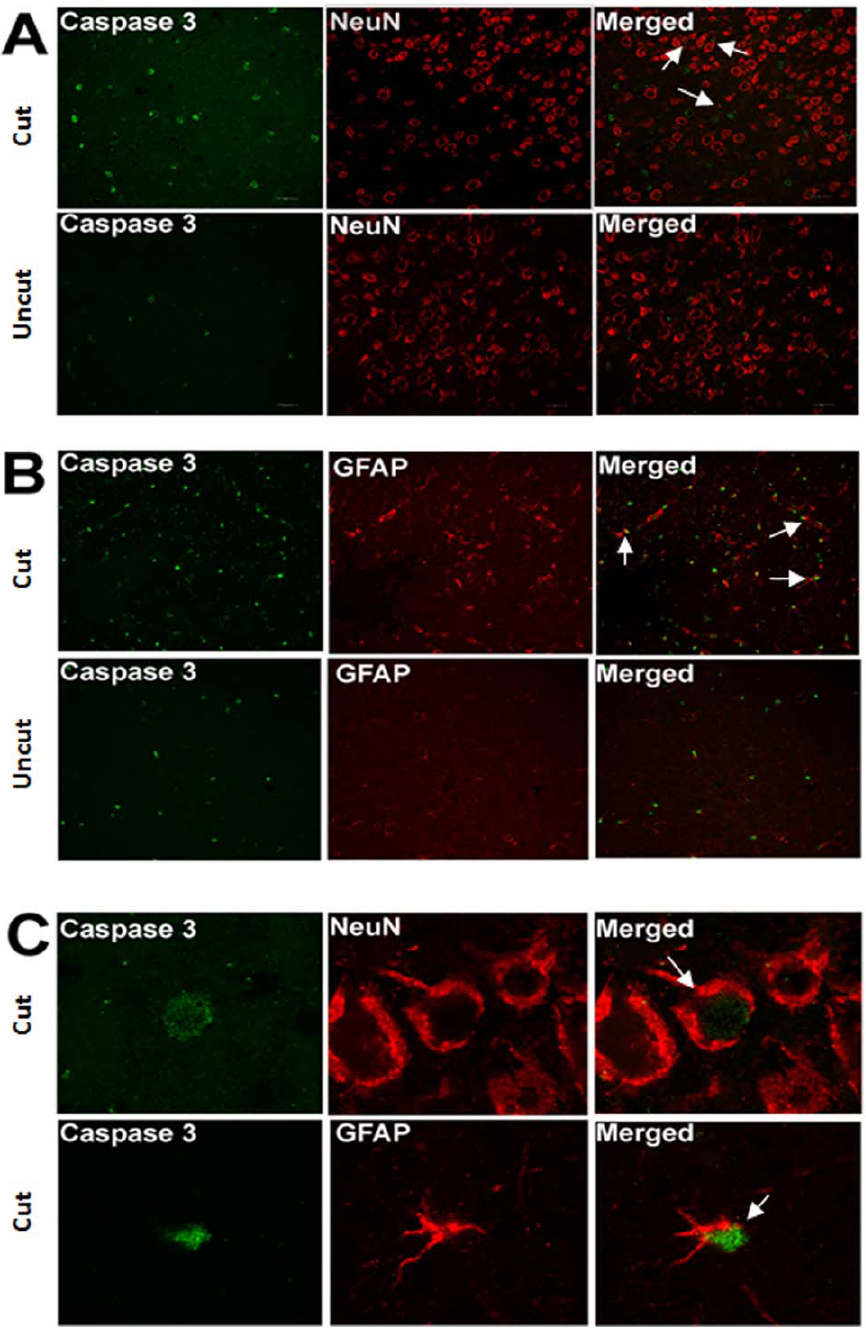
Caspase 3/NeuN and Caspase 3/GFAP in individual cells.